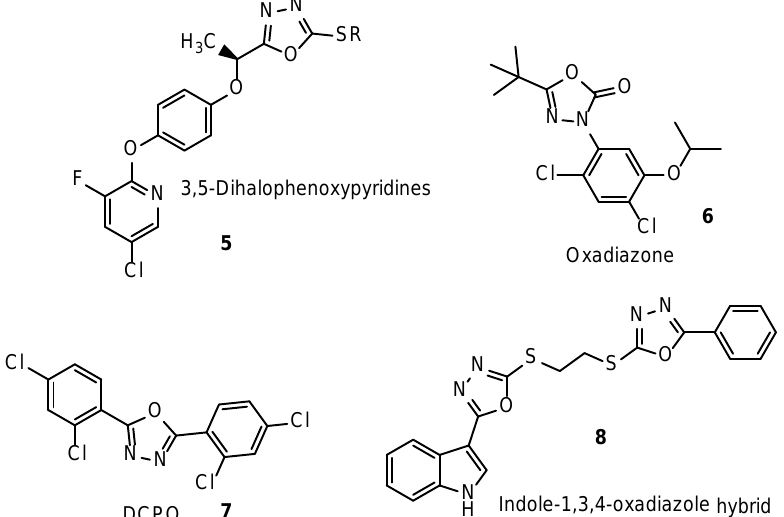
Figure 5. Compounds with herbicidal, insecticidal, and antibacterial activity: 3,5-dihalophenoxypyridines [78], oxadiazone [86], 2,5-bis(2,4-dichlorophenyl)-1,3,4-oxadiazole (DCPO) [87], and indole-1,3,4-oxadiazole hybrid [85].